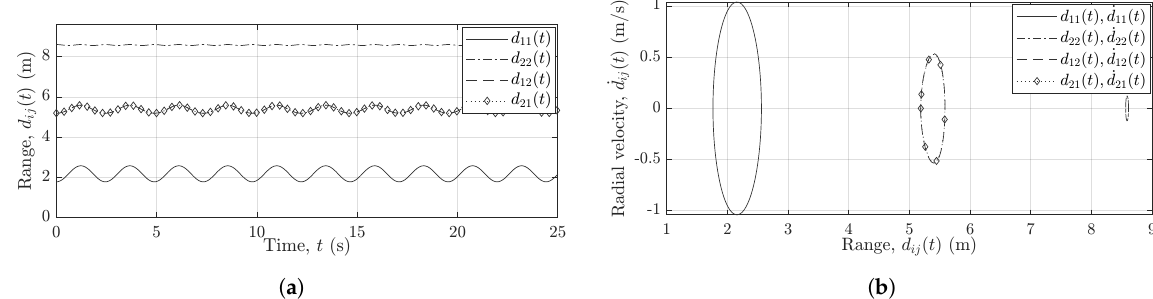
Figure 9. ( a ) The analytical radial range components d ij ( t ) and ( b ) the analytical radial velocity components ˙ d ij ( t ) for ( L T x ) (cid:54) = ( L T x ) . , L R x , L R x 2 2 1 1 The relation in (27) is utilized to obtain the measured mean Doppler shift B